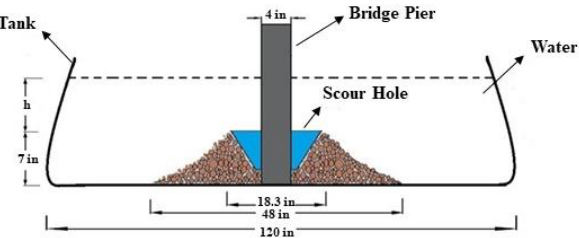
Figure 1. Schematic diagram of experimental set-up [34,35] (used with permission).